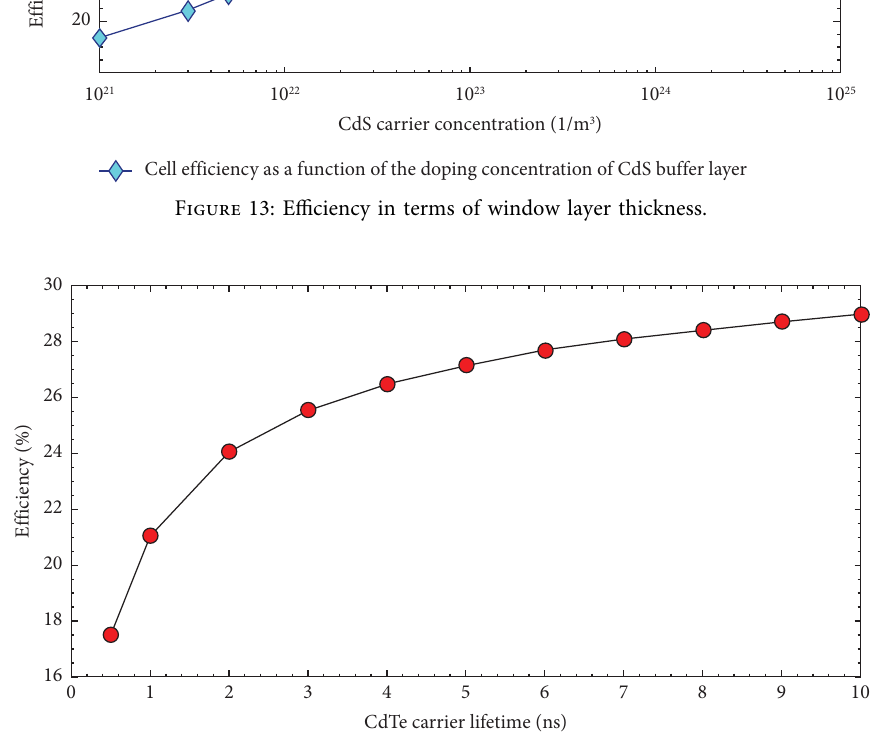
Figure 14: Solar cell efciency in terms of carrier lifespan in the absorber